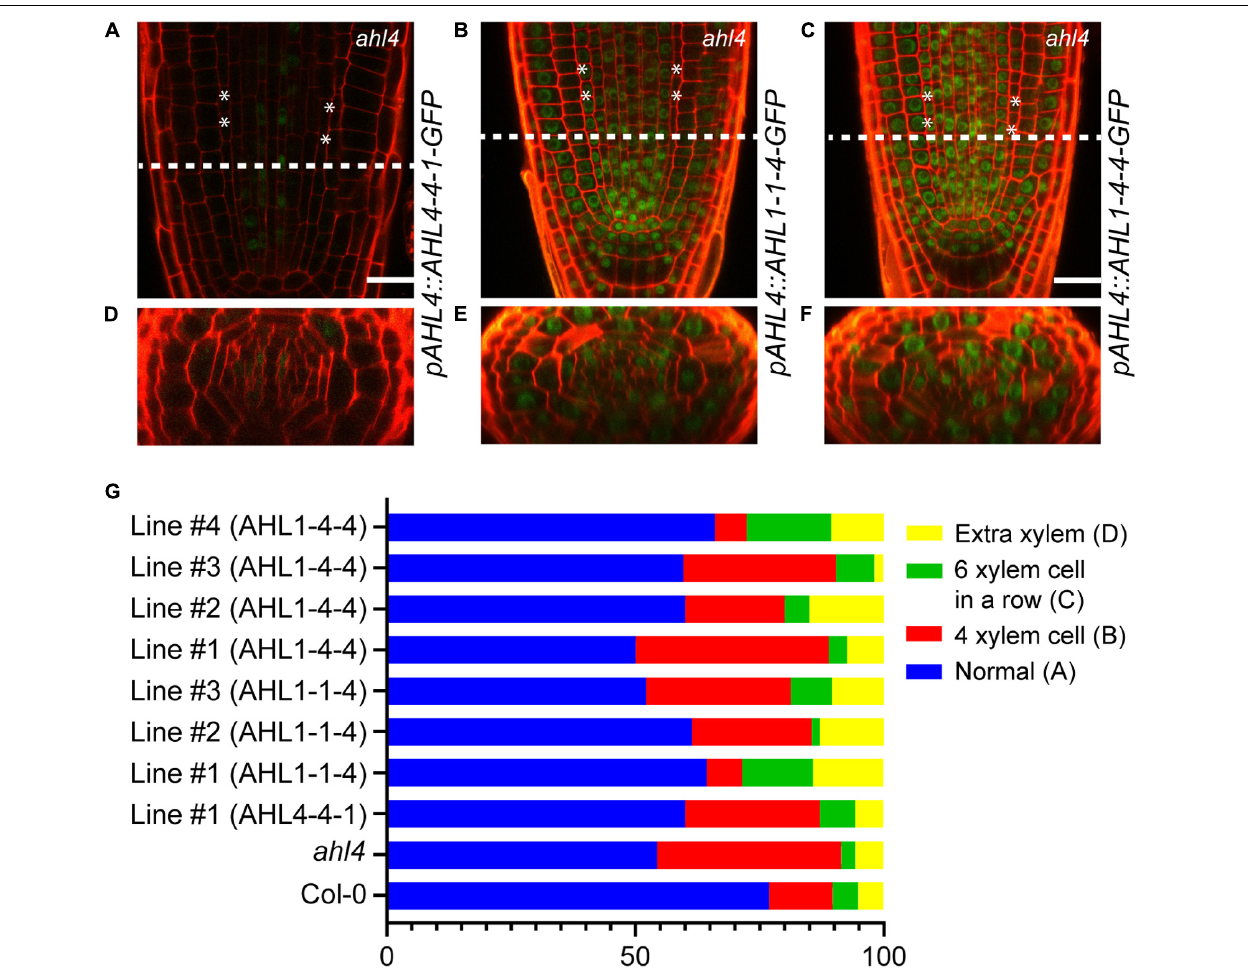
FIGURE 6 | Xylem phenotype rescue of the ahl4 mutant by chimeric proteins expressed under the AHL4 promoter. Longitudinal views of root apical meristems expressing pAHL4:AHL4-4-1-GFP (A) , pAHL4:AHL1-1-4-GFP (B) , and pAHL4:AHL1-4-4-GFP (C) . (D–F) Cross-sectional images of the dashed-line positions of panels (A–C) . Scale bars = 20 µ m. (G) Distribution of xylem phenotypes of the wild type, ahl4 , and ahl4 expressing pAHL4:AHL4-4-1-GFP , pAHL4:AHL1-1-4-GFP , and pAHL4:AHL1-4-4-GFP . Xylem phenotype categorization is identical to that in Figures 5A–D . n = 27 ∼ 70. All detailed scoring data are presented in Supplementary Table 2